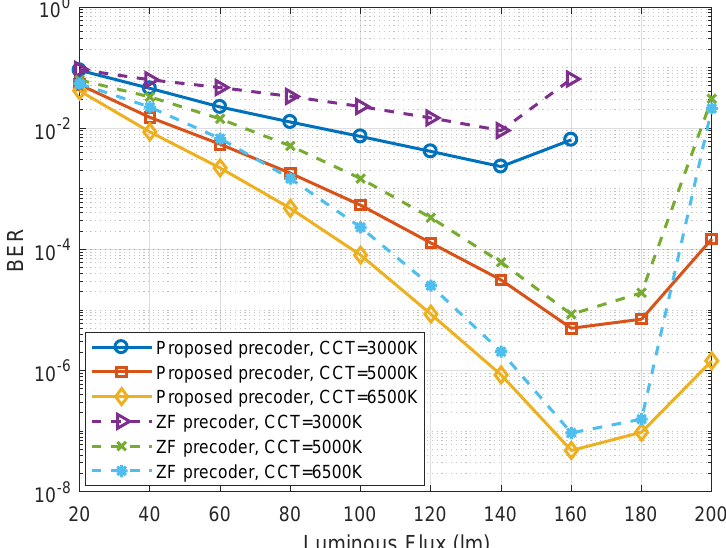
Figure 7. The BER performance of the proposed precoder and ZF precoder versus luminous flux with different CCT values when η = 0.01.